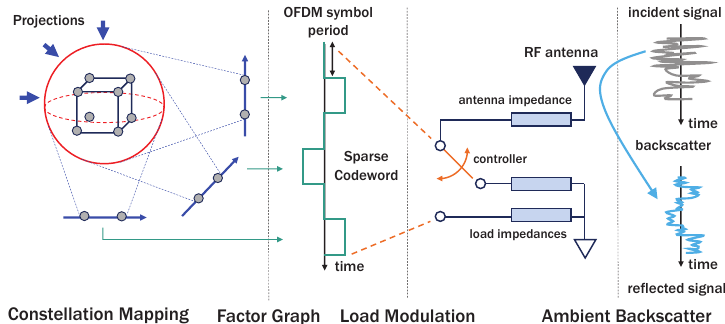
Figure 3. Brief overview of MSC-AmBC modulation at RF tags.